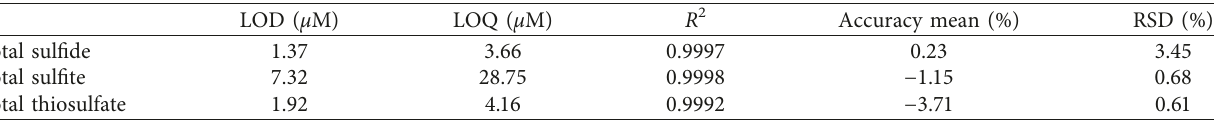
Table 3: Main qualitative parameters of the method obtained for the different chemical species: limits of detection and quantification (LOD and LOQ), linearity ( R 2 ), accuracy mean, and relative standard deviation (RSD).